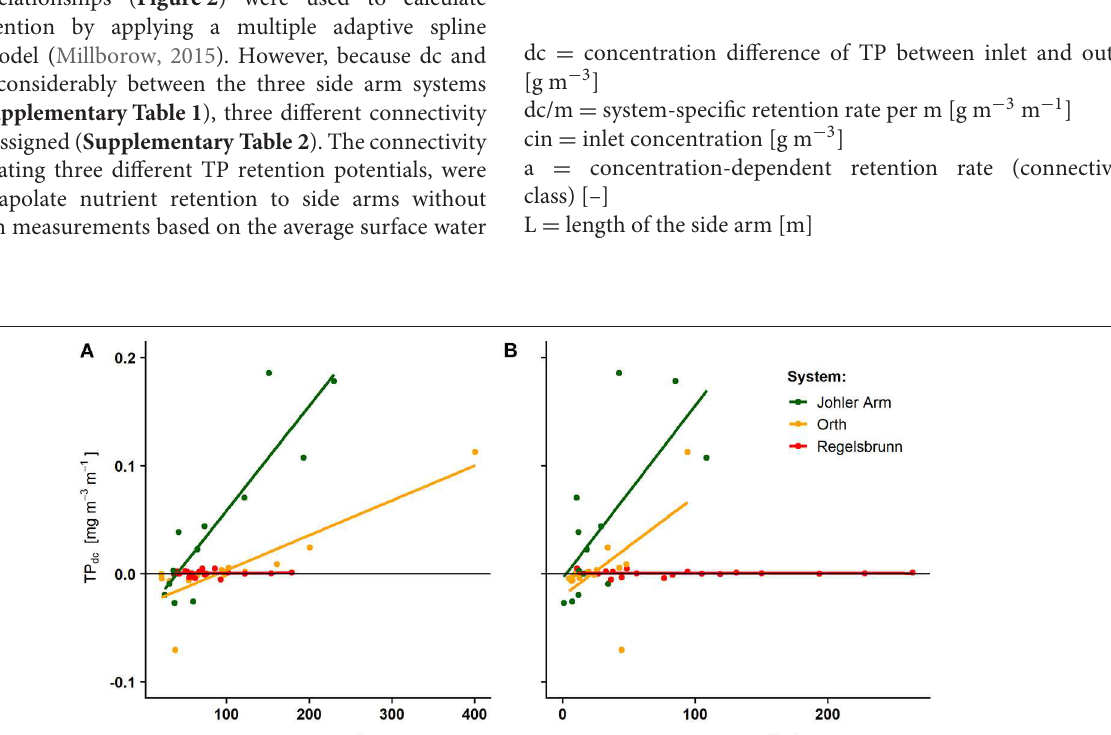
Frontiers in Environmental Science |